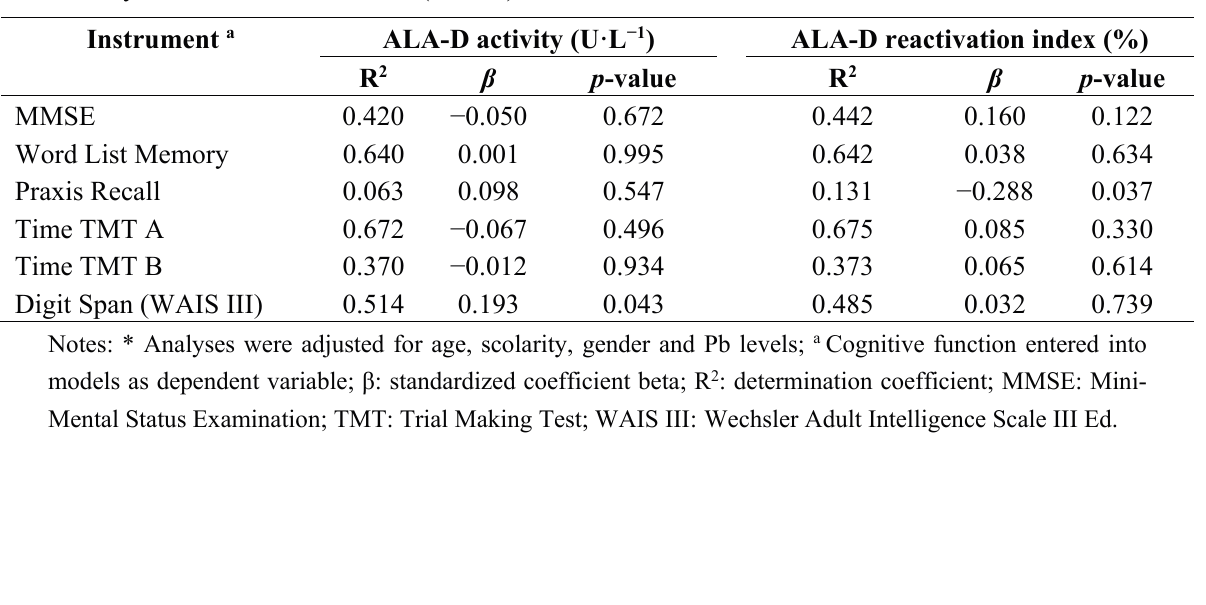
Table 3. Regression models of the association between cognitive performance and ALA-D activity and reactivation index ( n = 70).